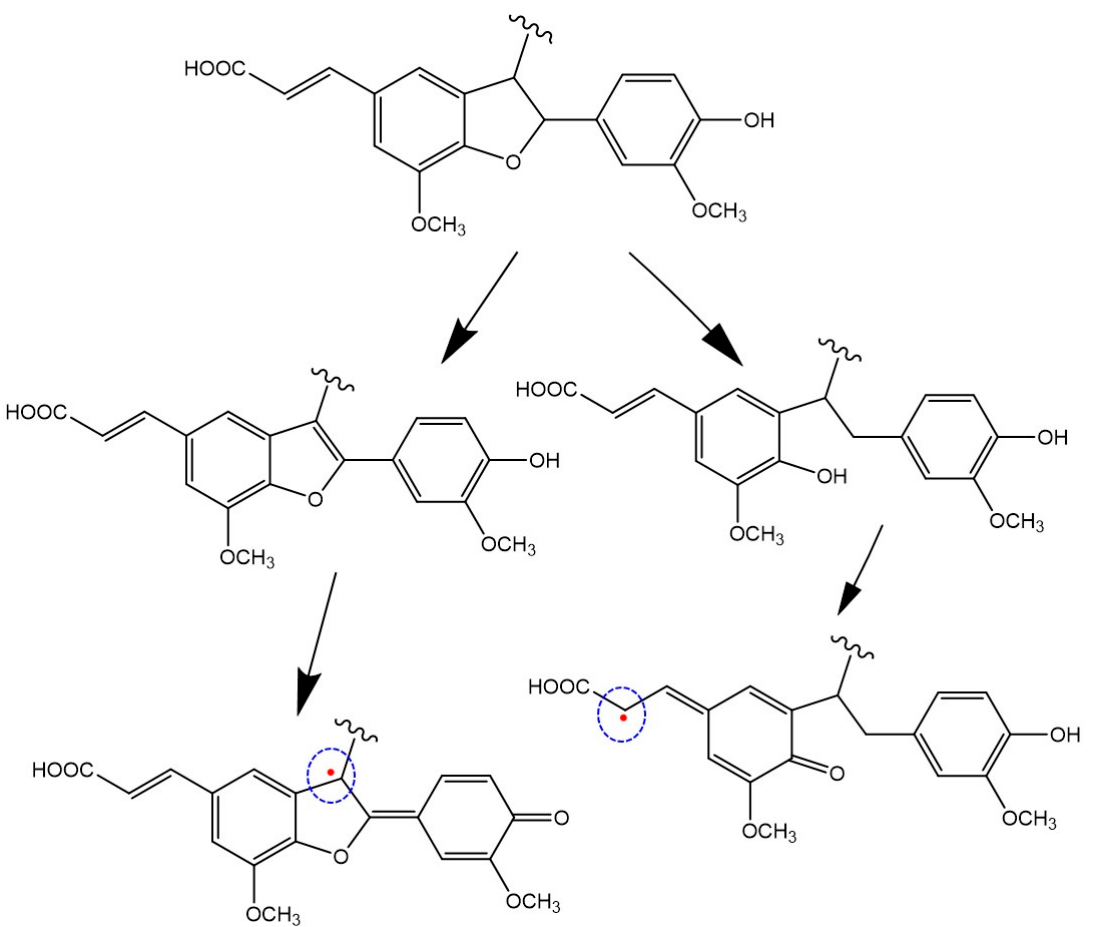
Figure 8. Proposed representative structural modifications and new paramagnetic centers induced on PolyFER by the hydrolytic treatment.